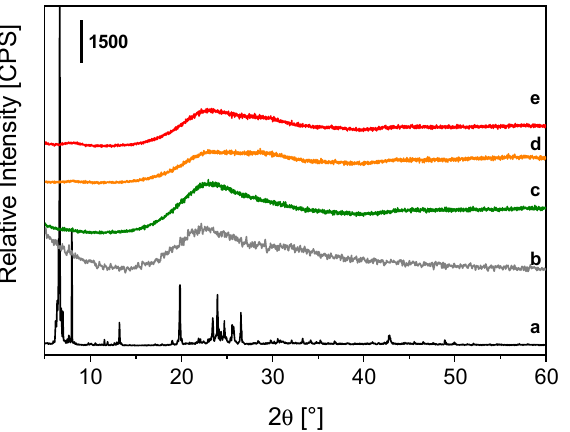
Figure 1. X-ray powder profiles of OctaTMA POSS (a), PSQ [24] (b), Tb-PSQ (c), TbEu-PSQA (d) and TbEu-PSQB (e).